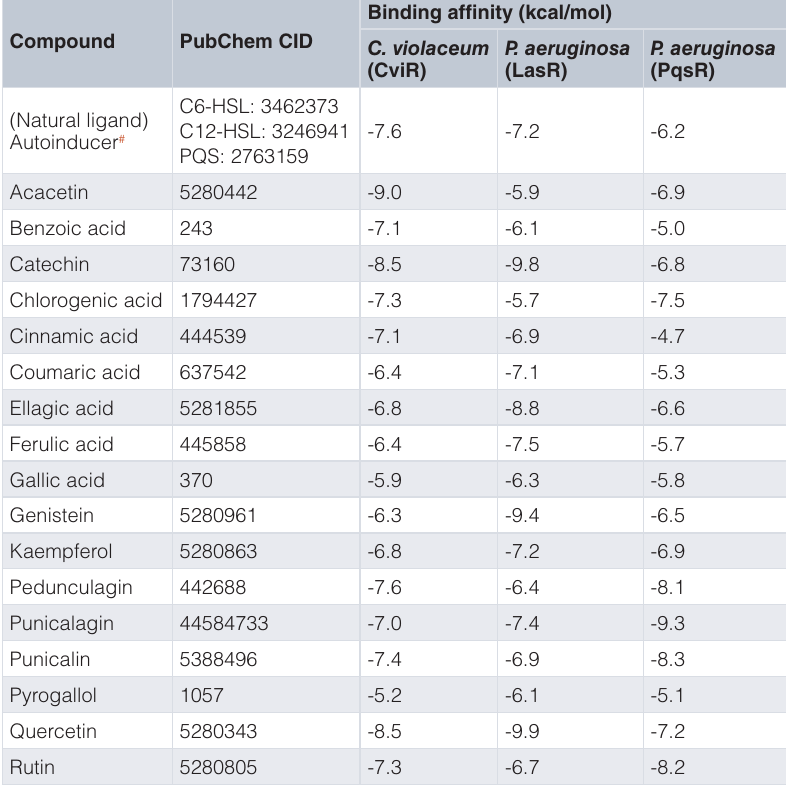
Table 2. Docking score of compounds with various